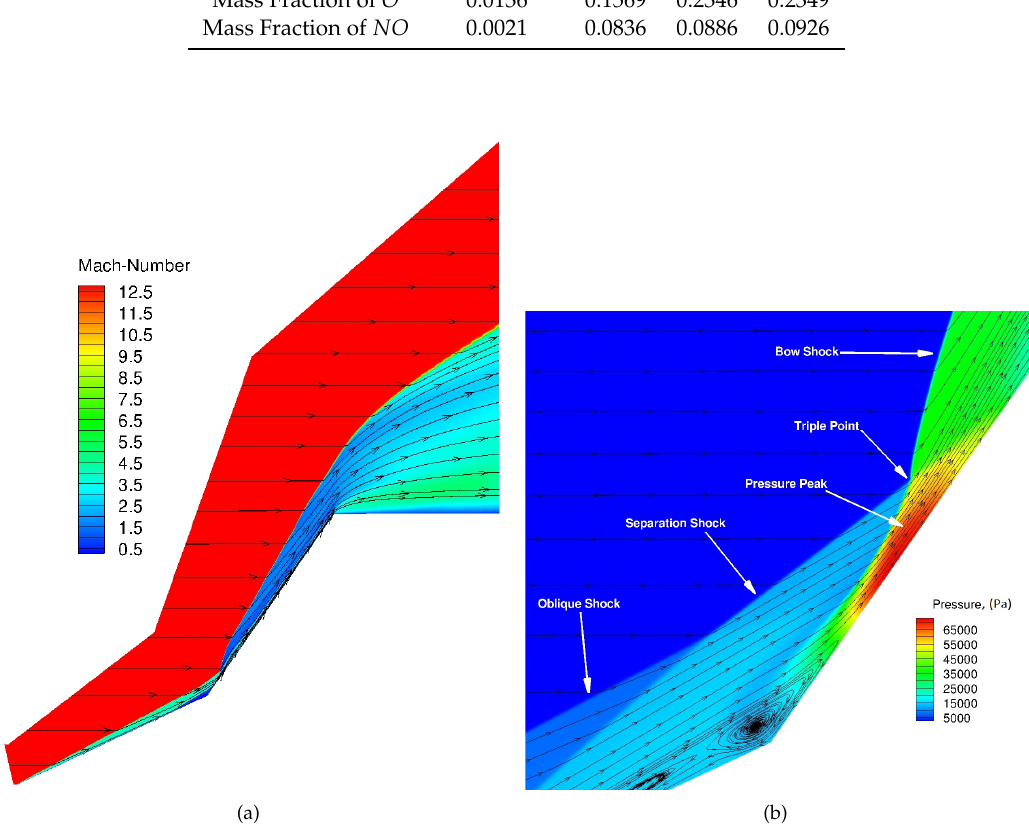
Figure 12. Flow field structure for Run 4, Table 1, using the non-equilibrium Navier–Stokes model (non-catalytic). ( a ) Overall flow field; ( b ) Enlargement of flow